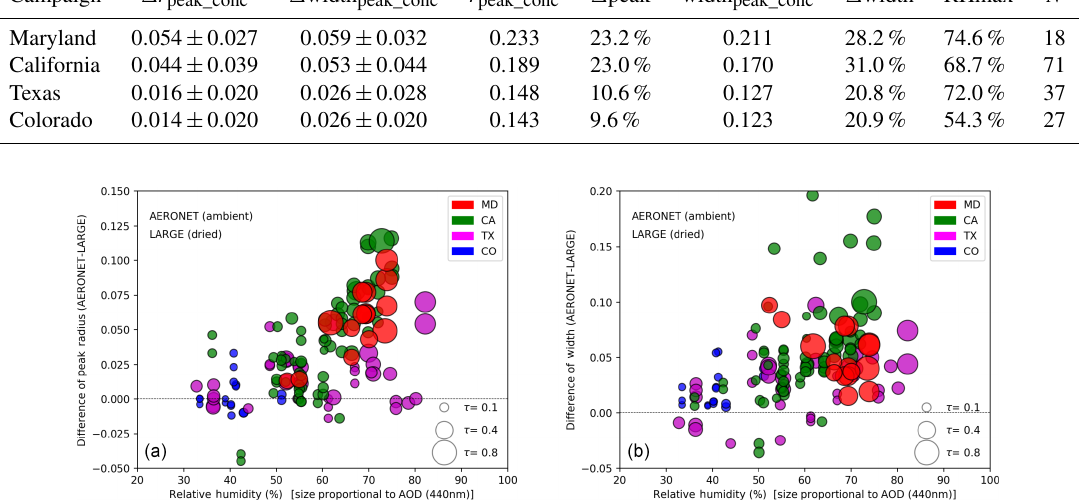
Figure 3. Differences in (a) r peak_conc and (b) width peak_conc between AERONET (ambient aerosol) and LARGE (dried aerosol) versus profile relative humidity. The marker size is proportional to coincident aerosol optical depth (440nm) from